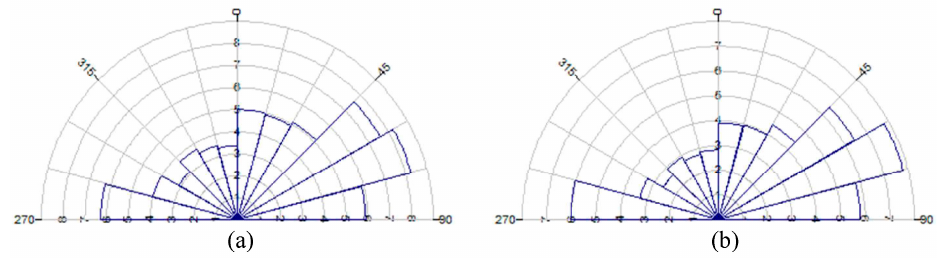
Figure 8. Distribution diagrams: ( a ) Frequency of linear structures; ( b ) Length of the linear structures.